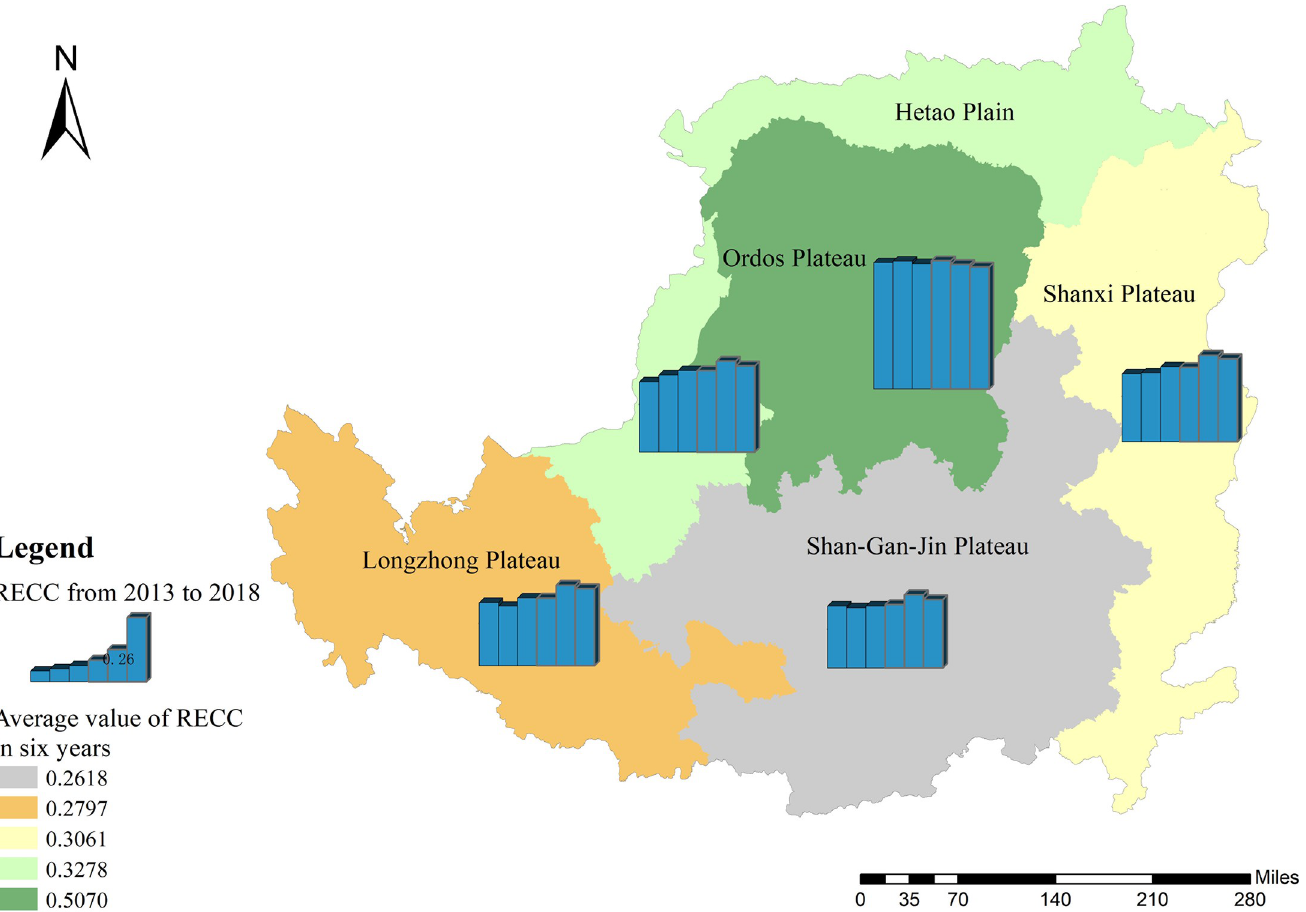
Fig 7. Temporal and spatial pattern of resource and environmental carrying capacity index. The image was obtained by using ArcGIS 10.2 through the open- access data process. The spatial extent of the Loess Plateau was obtained from the Resource and Environmental Science Data Center of the Chinese Academy of Sciences